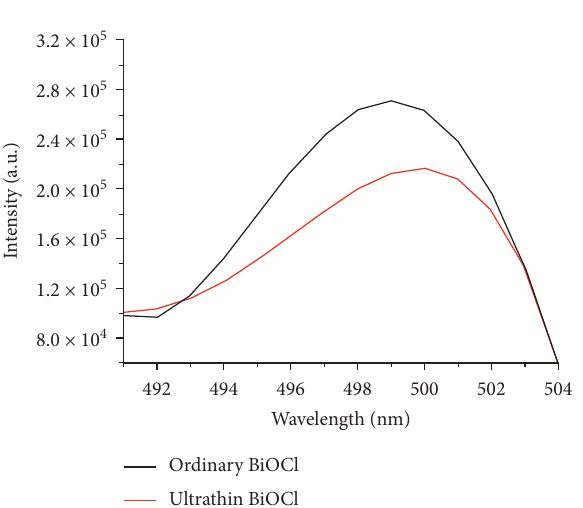
Figure 8: PL spectra of ordinary BiOCl and ultrathin BiOCl samples.